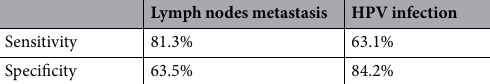
Table 3. Diagnostic value of MEG3 methylation (n = 168).